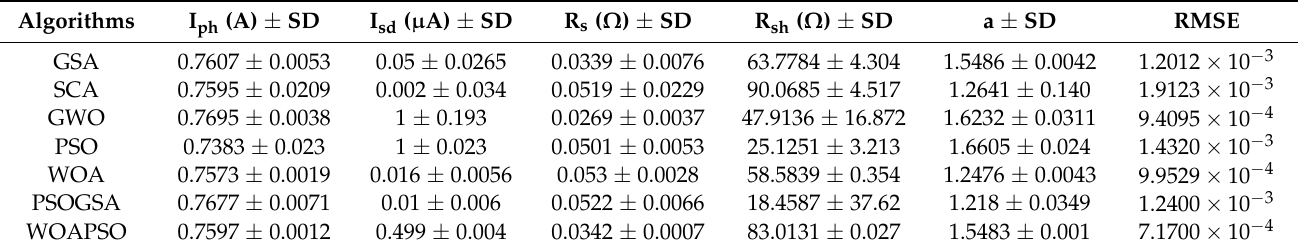
Table 2. Comparison of WOAPSO with different parameter estimation methods for SDM.